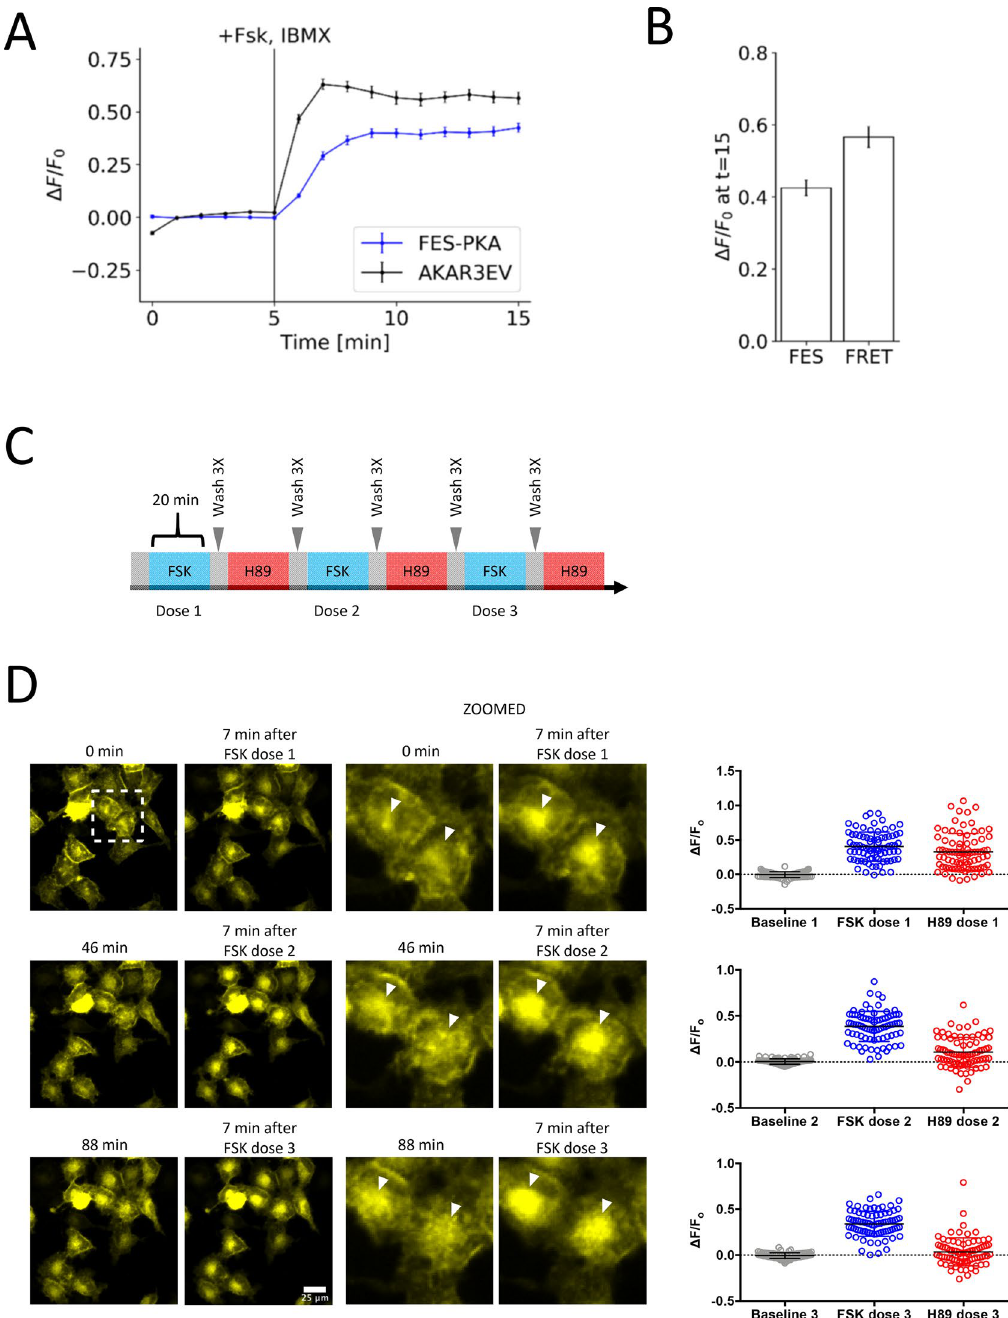
Figure 4. Characterization of FES-PKA as a PKA biosnesor. (A) Time-profile shows quantification of FES-PKA response in comparison to a PKA FRET sensor (AKAR3EV) in response to PKA activation. (B) Bar chart represents the signal change for the FES-PKA (FES) and AKAR3EV (FRET) 10 min after PKA activation. All data points represent an average signal intensity collected from 30 cells over 3 independent experiments (10 cells each), and error bars represents standard error of mean. * represents statistical significance: p < 0.05. Scale bar represents 10 µm. (C) Drug treatment protocol highlights repeated stimulation with 50 μM FSK (Dose 1,2 and 3) and 40 μM H89 for 20 min intervals with three washes in between each change in treatment. (D) Epifluoresence and zoomed images (corresponding to dotted square) of HeLa cells overexpressing FES-PKA undergoing treatment described in (A). Times 0, 46, and 88 min are image frames immediately preceding FSK treatments, and corresponding images to the right are taken 7 min after FSK doses 1, 2 and 3. Arrowheads indicate the endomembrane regions that exhibit cycles of an increase and a decrease of the FES-PKA localization. Quantifications of normalized change in fluorescence (ΔF/ F o ) of FES-PKA at endomembranes during treatment in (A) are presented on the right panel. Measurements of ΔF/ F o for FSK and H89 doses 1, 2 and 3 are taken 7 and 10 min after drug administration, respectively. Measurements of of ΔF/F o for baseline 1, 2 and 3 are taken from the timepoint immediately prior to FSK treatment. Normalization F o is determined by averaging the 5 timepoints prior to each FSK dose. (N = 3/experimental condition, 81 cells) Scale bar applies for non-zoomed images, and represents 25